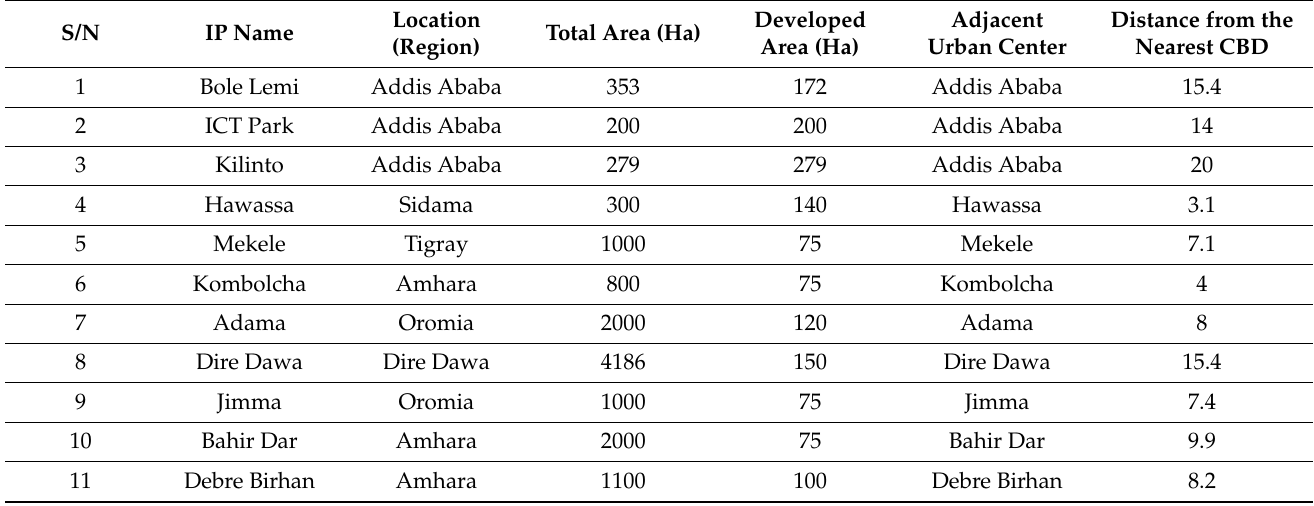
Table 3. Location of federal-owned functional IPs.